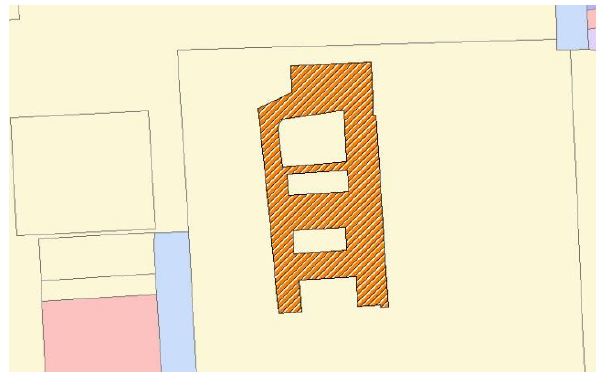
Figure 6. The impervious surface (the orange slash part) in LCA was integrated in the